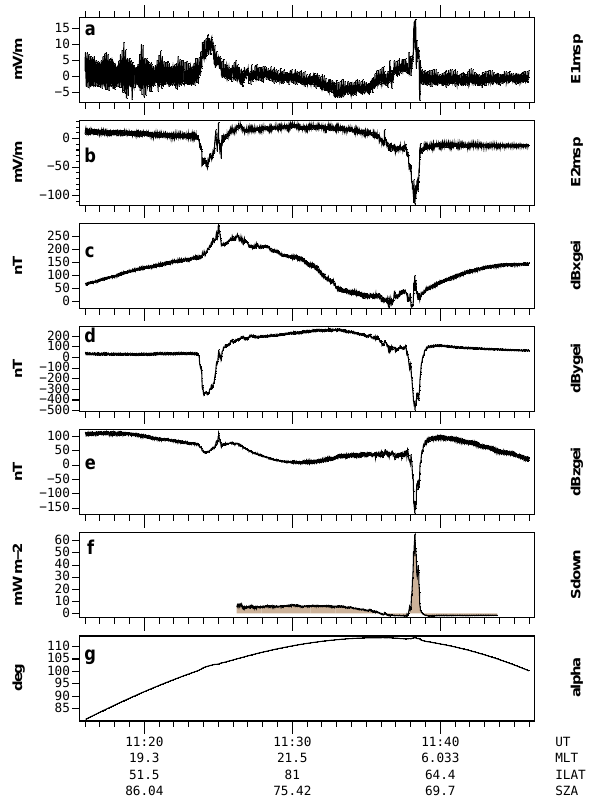
Fig. 1. Example plot used in visual inspection of events. (a–b) spin plane electric field in msp coordinates, (c–e) IGRF-subtracted magnetic field in GEI coordinates, (f) calculated downward field- aligned Poynting flux, (g) angle α between spin axis and magnetic field, Poynting fluxes for 75 ◦ <α< 105 ◦ were not shown in panel (f).